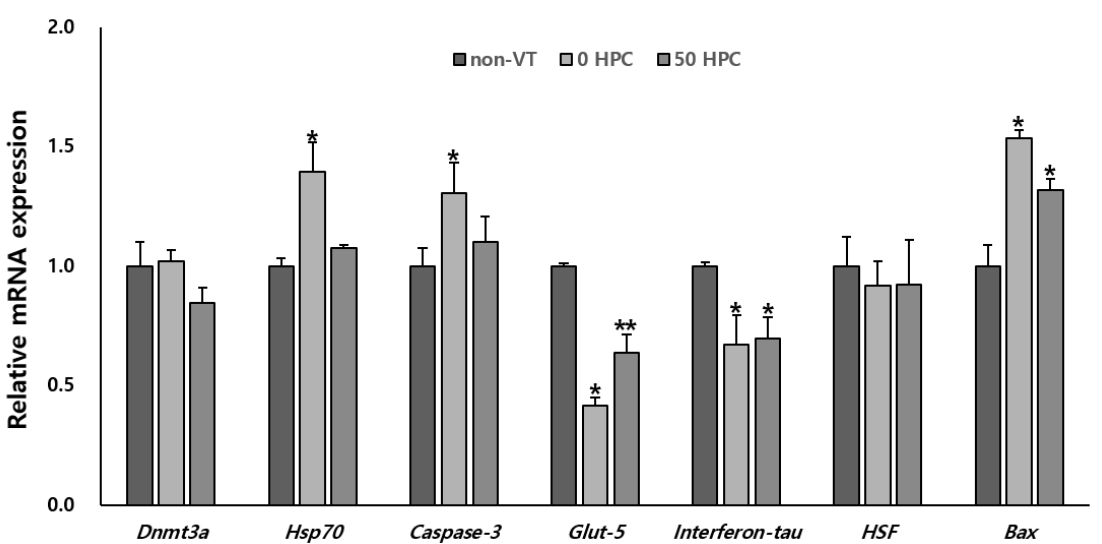
Figure 5. mRNA expression levels of genes ( Dnmt3a , Hsp70 , Caspase-3 , Glut-5 , Interferon-tau , HSF , and Bax ) related to development potential in blastocysts produced via PA in the non-VT, 0 HPC, and 50 HPC groups. The internal standard used β-actin gene. * p < 0.05 compared with the non-VT group. ** p < 0.05 compared with the non-VT and 0 HPC groups.